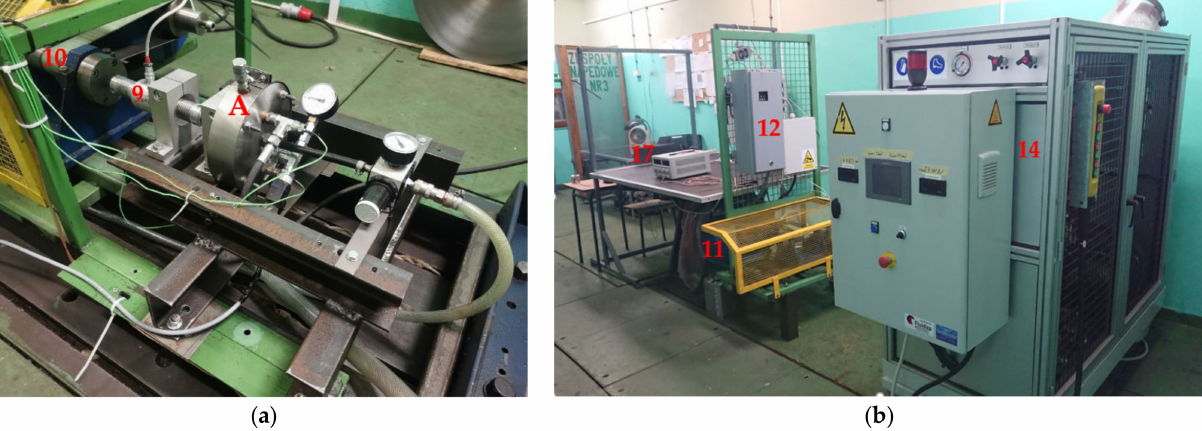
Figure 2. Photos of the test bench: ( a ) view of the test module; ( b ) general view of the test rig Description in text